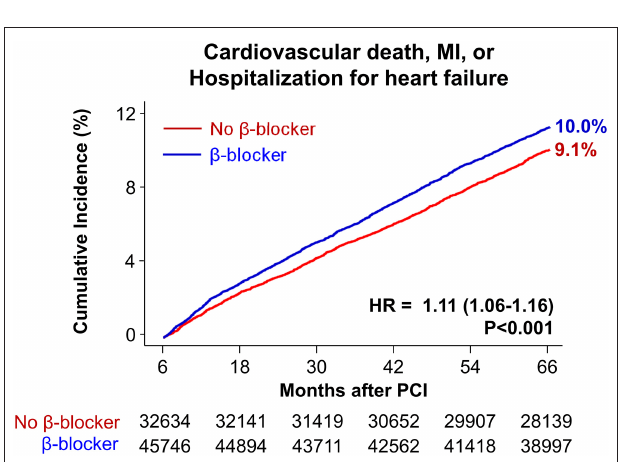
FIGURE 2 | Time-to-event curves for major adverse cardiovascular events for 5 years after PCI. The cumulative incidence of major adverse cardiovascular events for 5 years after PCI. HR, hazard ratio; MI, myocardial infarction; PCI, percutaneous coronary intervention.